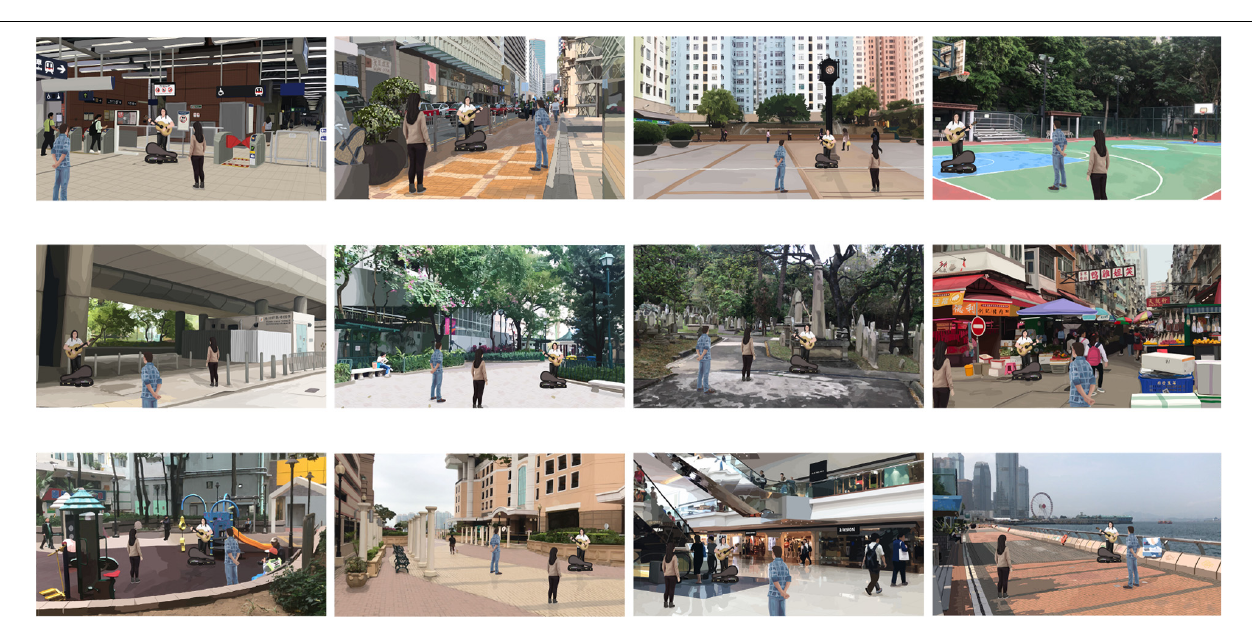
FIGURE 1 | Pictorial stimuli of public spaces without street performance (top row, from left to right, transport facility, street, square, and recreational space; middle row, from left to right, found neighborhood space, park, memorial, and market; and bottom row, from left to right, playground, community open space, indoor marketplace, and waterfront).